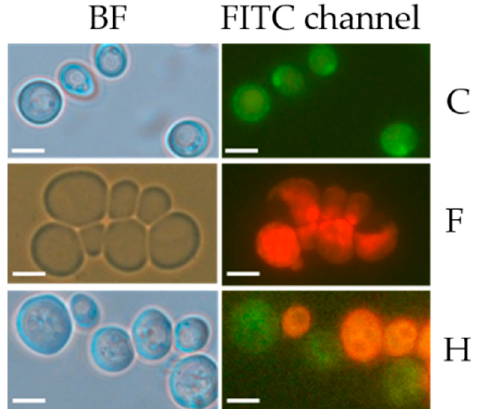
Figure 3. The effects of fagopyrin and hypericin on yeast cells. Yeast cells imaged by fluorescence microscopy in FITC channel using 488 nm laser excitation in cultures with no phytochemicals (C) and in the presence of 100 µM fagopyrin (F) or 100 µM hypericin (H) for 3 h. Cell showing natural green autofluorescence (C), red fluorescence under fagopyrin exposure (F) and a mixture of green (natural autofluorescence) and red fluorescence depending on cell cycle stage under hypericin exposure. After the addition of fagopyrin, cells arrested in mitosis cannot divide, whereas cells exposed to hypericin also have division defects and accumulate as large-budded cells. The same cells imaged in the bright field (BF). Microscopic images taken with 100× objective. Scale bar, 5 µm.